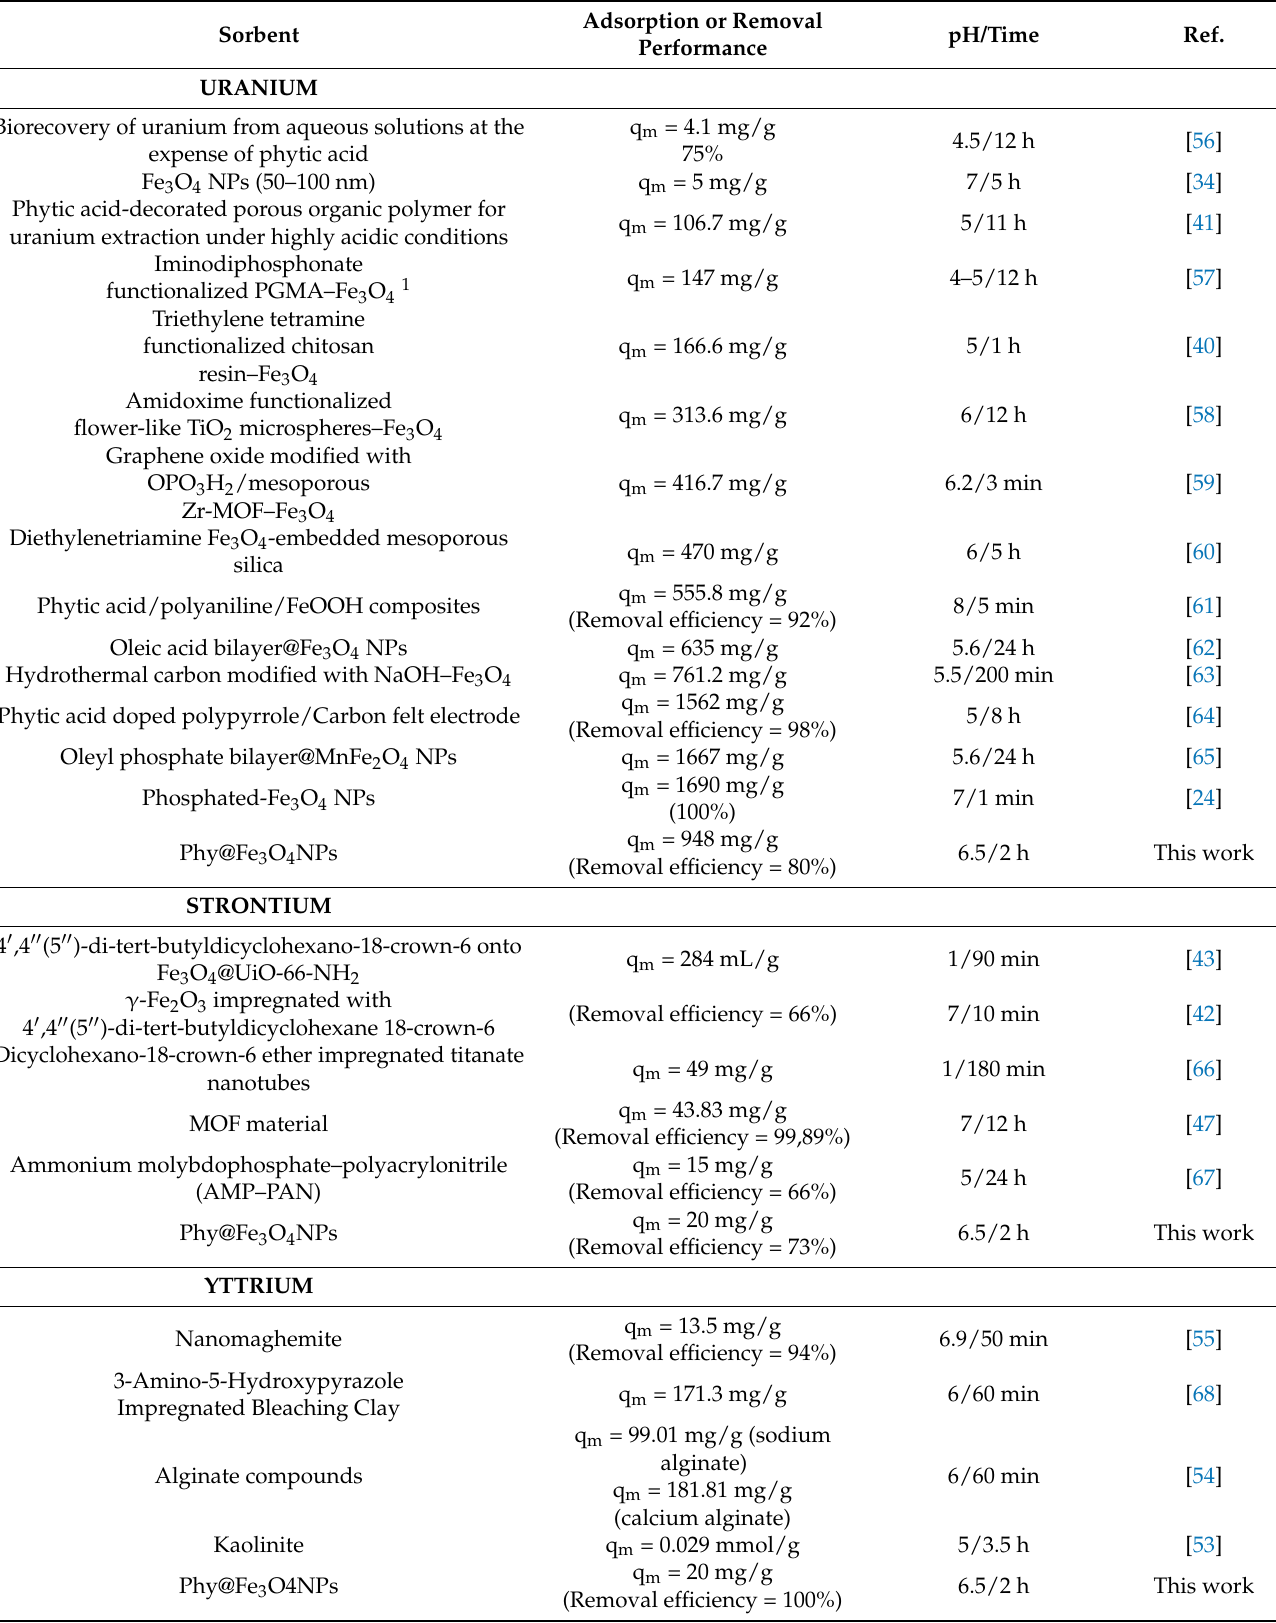
Table 2. Comparison of U(VI), Sr(II), and Y(III) adsorption capacities reported for adsorbents in published studies and the material in this